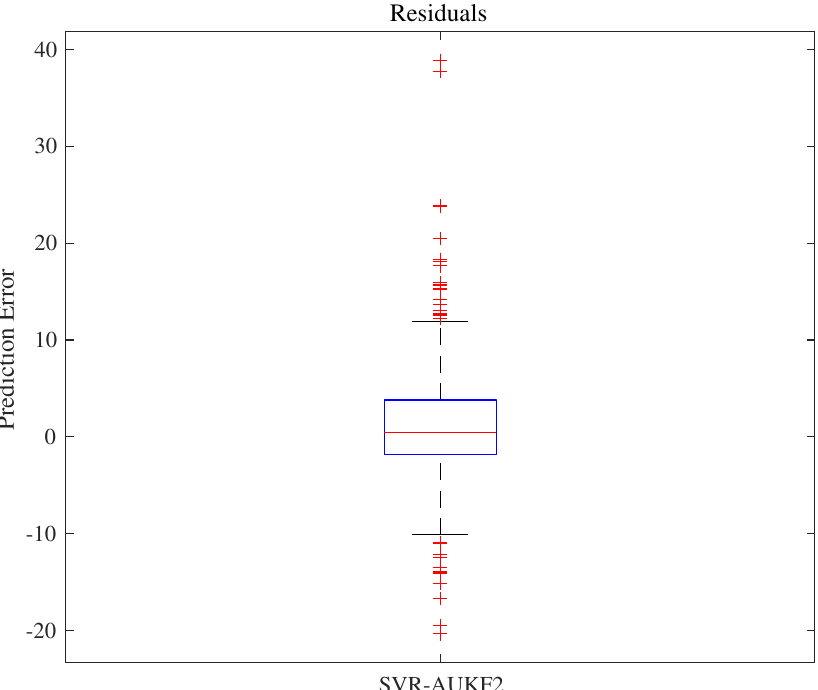
Figure 10. Boxplot of SVR-AUKF2 prediction residuals. Figure 9 shows the predicted PM 2.5 concentration based on SVR-AUKF2 method. The prediction value is closer to the measured PM 2.5 concentration in the time range of